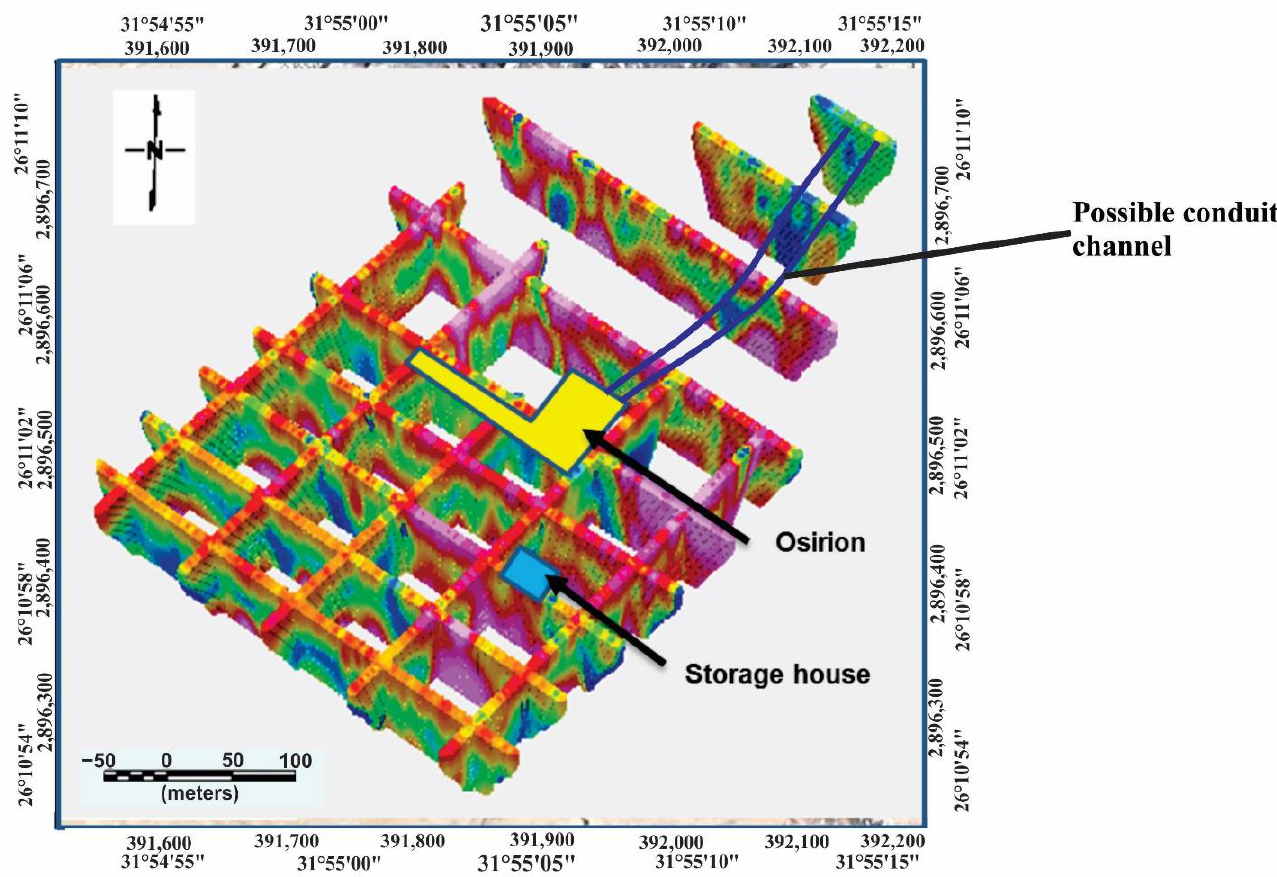
Figure 12. A 3D voxel model of the inverted electrical resistivity of profiles 1 to 14. This model explains that the resistivity value elsewhere is not the same. They change in both the horizontal and vertical directions due to the fluid content and lithology.